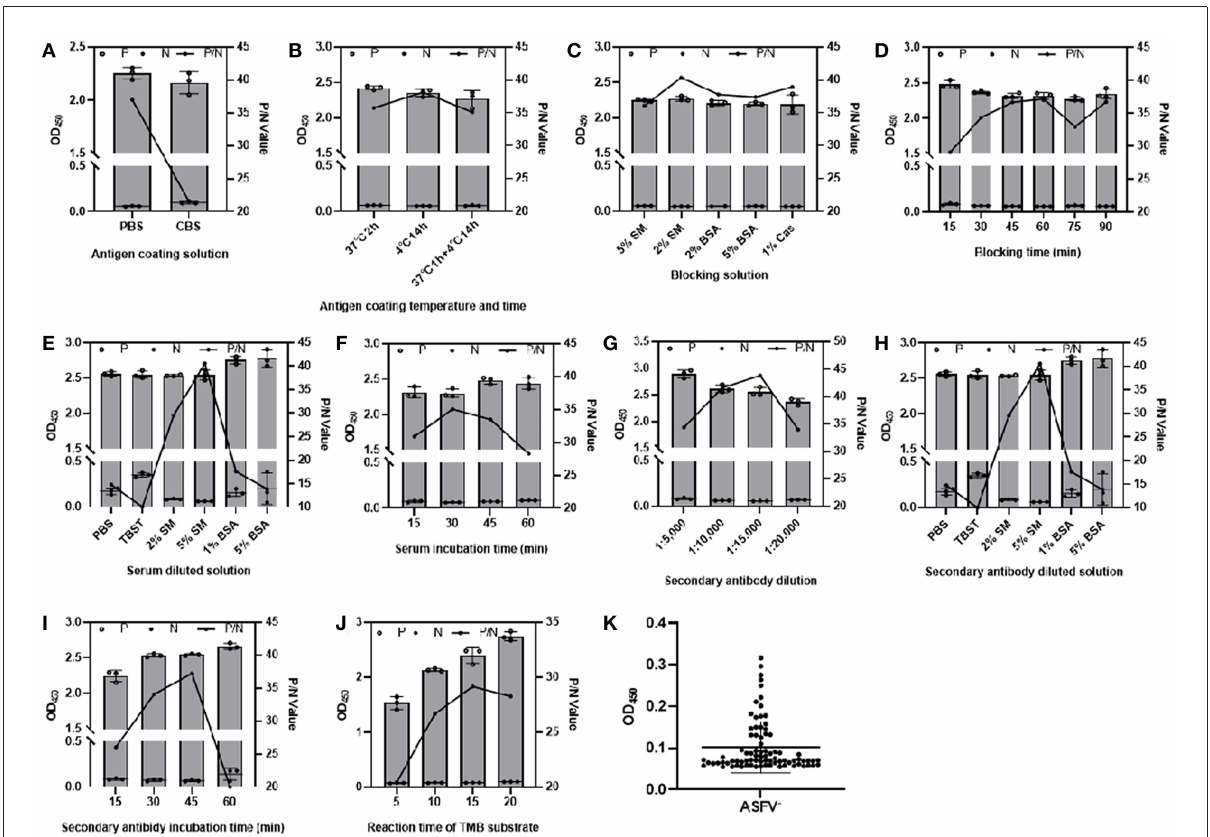
FIGURE3 Optimization of CD2v-iELISA conditions. The CD2v-iELISA method was optimized by changing the following parameters: antigen coating solutions (A) , antigen coating temperature and time (B) , blocking solution (C) , blocking time (D) , serum dilution (E) , incubation time (F) ; secondary antibody dilutions (G) , secondary antibody dilution factor (H) , secondary antibody incubation time (I) , TMB substrate incubation time (J) . P and N value data represent mean ± SD and P/N value data represent the ratios of positive mean value (P) to negative mean value (N). A total of 82 negative sera were analyzed to determine the cut-off value (K) .